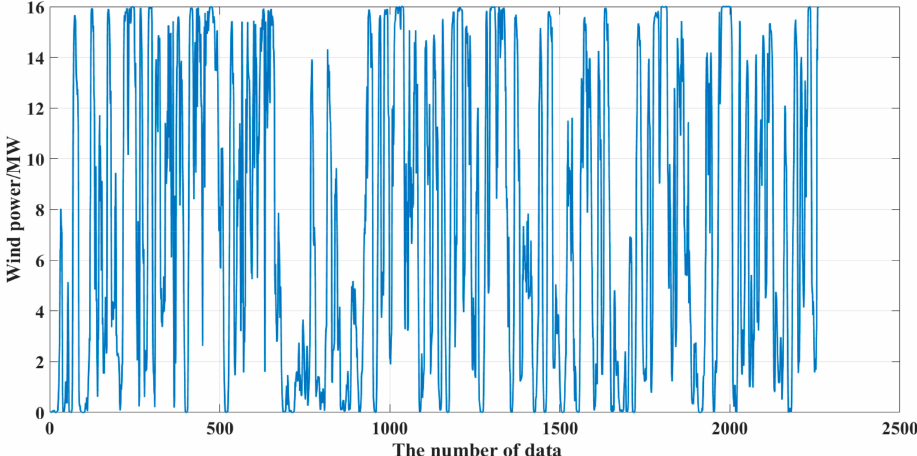
Figure 6. The output data of the wind farm used in this